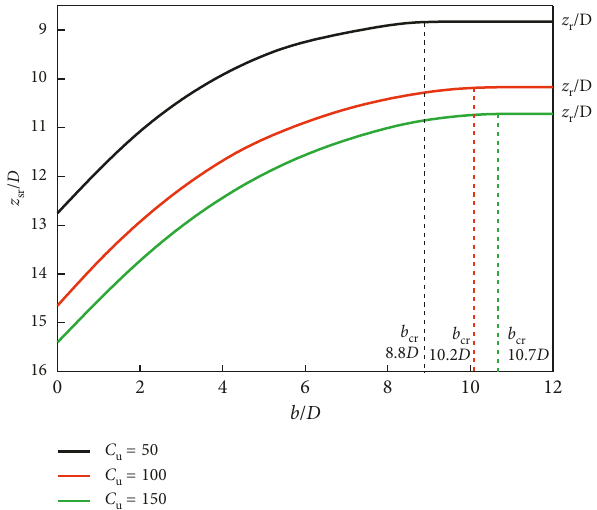
Figure 10: The relationship between z strength of soil ( θ � 45 ° ).